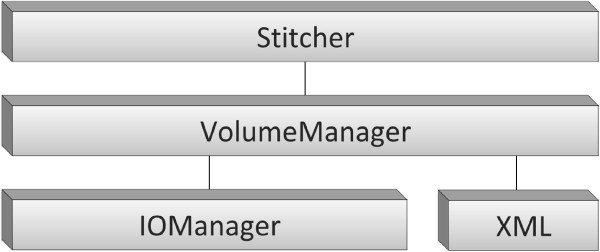
The software architecture of TeraStitcher. The architecture of the proposed TeraStitcher tool is composed by four modules organized in three layers with growing abstraction levels. At the lowest abstraction level, the IOManager and XML modules contain input/output routines for data and metadata, respectively. The middle layer contains the VolumeManager module, which is responsible to model data organization and to access both data and metadata through functionalities provided by the lower layer. At the top layer, the Stitcher module implements the stitching pipeline.